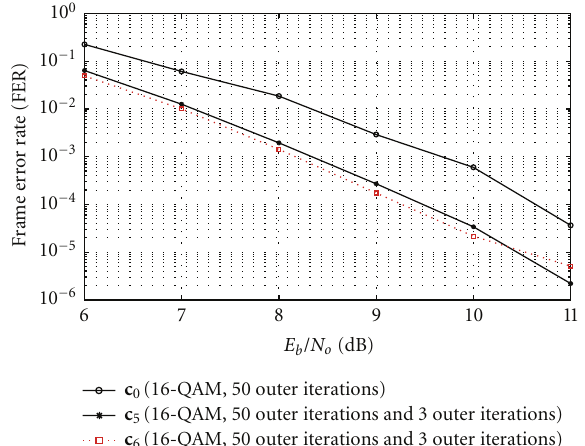
Figure 2: FER performances of the proposed LDMCs c 5 and c 6 with 16QAM